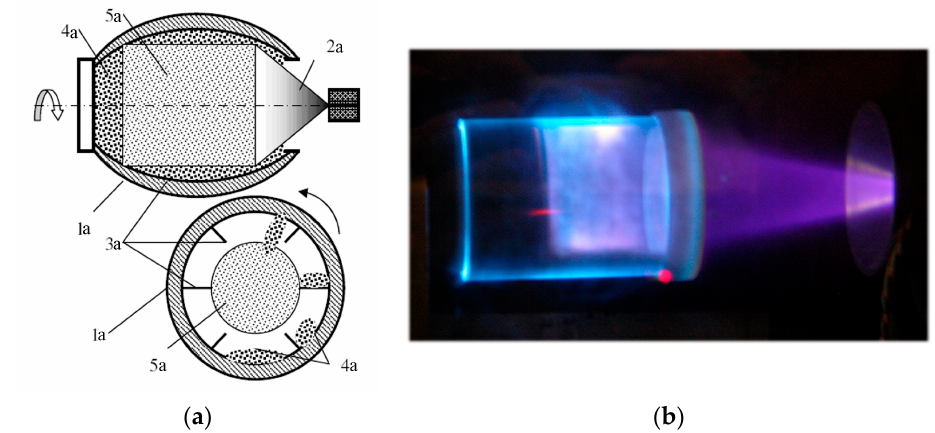
Figure 2. Polysaccharide powders processing in the mixing device: ( a ) Design of the mixing device for the EBP-treatment of polysaccharide powders: 1a—cylindrical quartz vessel; 2a—the EBP cloud; 3a—internal partitions; 4a—polysaccharides powder; 5a—aerosol reaction zone. ( b ) Chitin powder